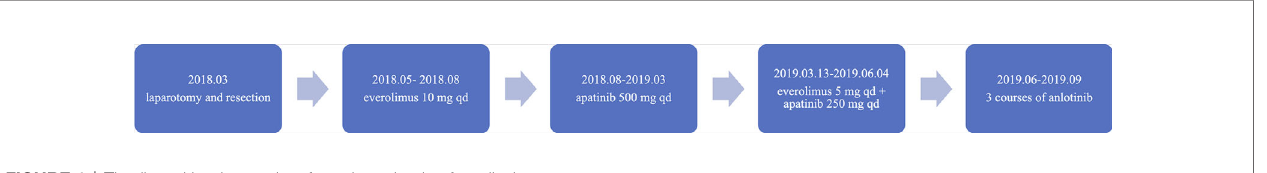
FIGURE 1 | Timeline with relevant data from the episode of medical